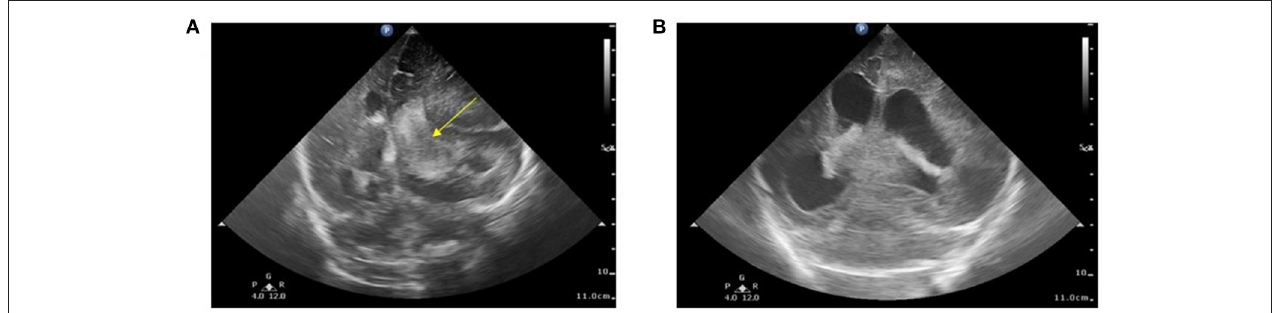
FIGURE 1 | (A) Brain echo at 3 days of age. Bilateral intraventricular and intracranial hemorrhage with ventricular enlargement and midline shift to the right. The arrow indicates the blood clot involved in the left ventricle (Grade 3). (B) Brain echo at 16 days of age. Hemorrhage resolved after the 14-day replacement therapy. Image shows post-hemorrhagic